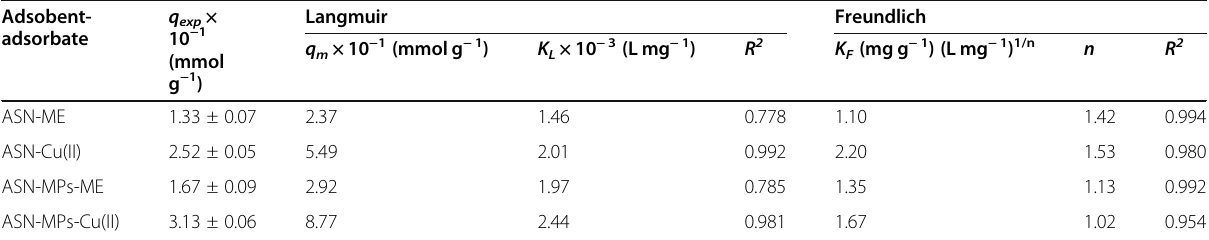
Table 3 Adsorption isotherm parameters of ME and Cu(II) cations on ASN and ASN-MPs at 27 °C, pH 7, and 90 min of contact time Adsobent-